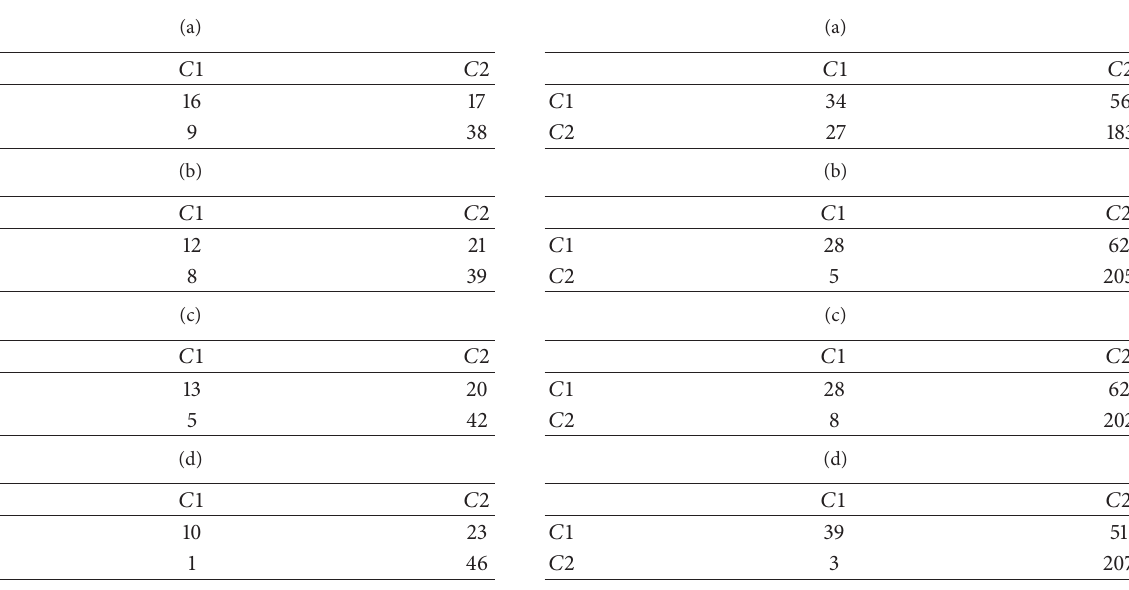
Table 9: Confusion matrices of (a) Adaboost, (b) Bagging, (c) RSM, and (d) proposed approach using Heart dataset.